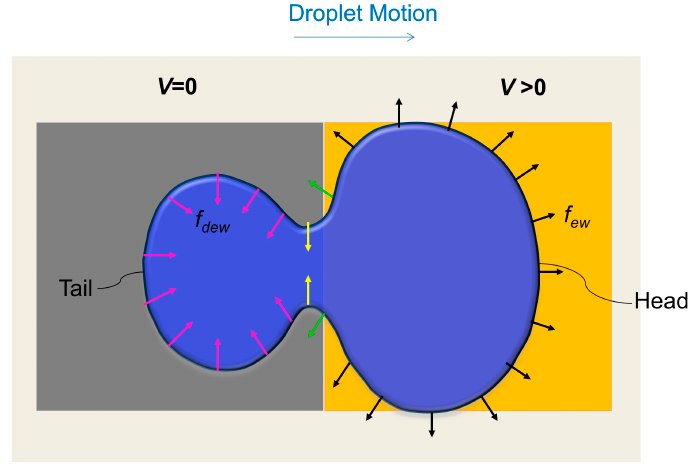
Figure 1. A droplet during transition from a grounded electrode to an activated one (Top view). Electrowetting force, f ew (black arrows), and dewetting force, f dew (pink arrows), on triple point contact line are shown. The green and yellow arrows show the dewetting and wetting forces adjacent to the junction of the activated and grounded electrodes.